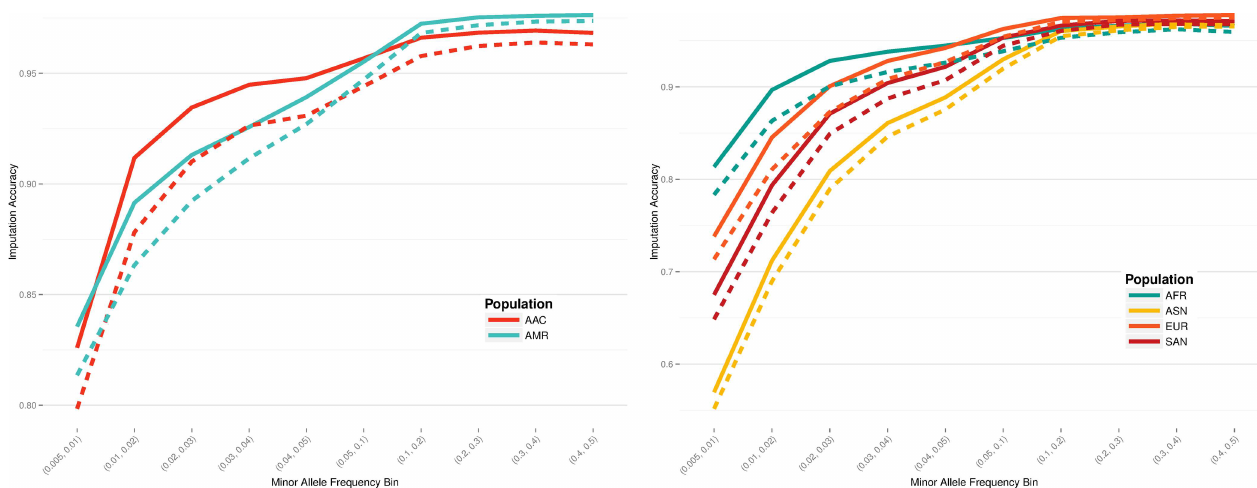
Fig 2. Improved imputation accuracyfound with custom content sites in regions of interest. Solid lines denotethe imputationaccuracy of MEGA including the custom content, whiledashed lines indicate the performance of MEGA without the custom content. Admixedpopulationsare on the left, with continental populations found on the right.